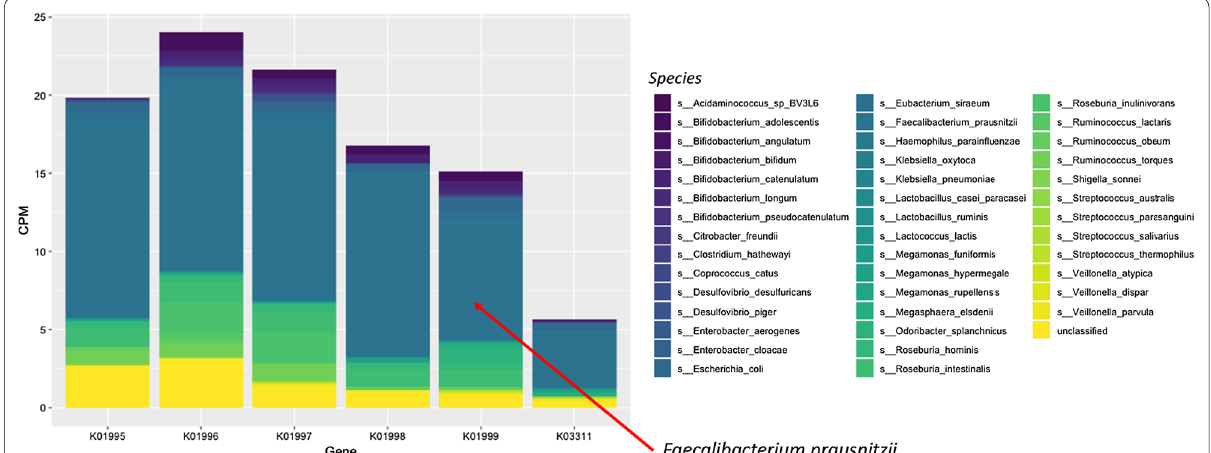
Fig. 3 Mean abundance of bacterial transport gene families stratified by species. The plot includes the 42 species encoding at least one of the gene families and the counts explained by unclassified taxa. CPM counts per million